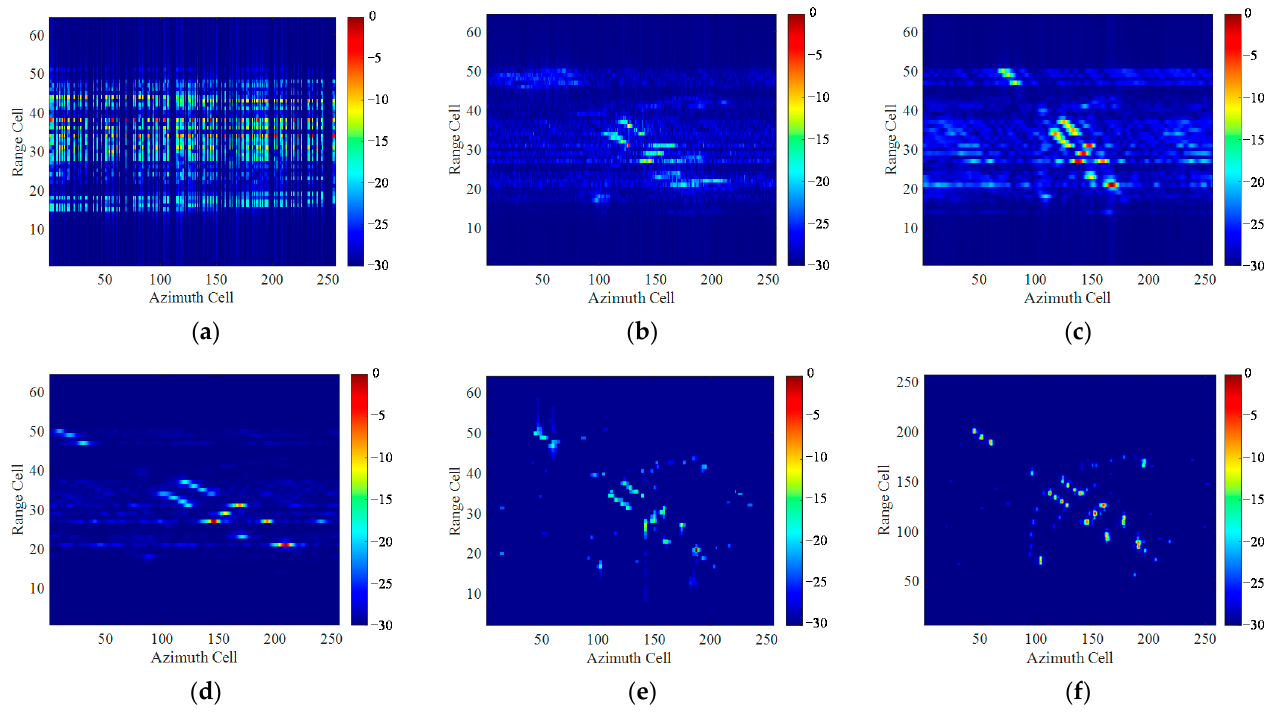
Figure 14. Imaging results of Boeing-727 data under 40% sampling ratio by different methods: ( a ) The down-sampled echo signal; ( b ) RD algorithm; ( c ) STFT algorithm; ( d ) SPWVD algorithm; ( e ) RWT algorithm; ( f ) the proposed method.